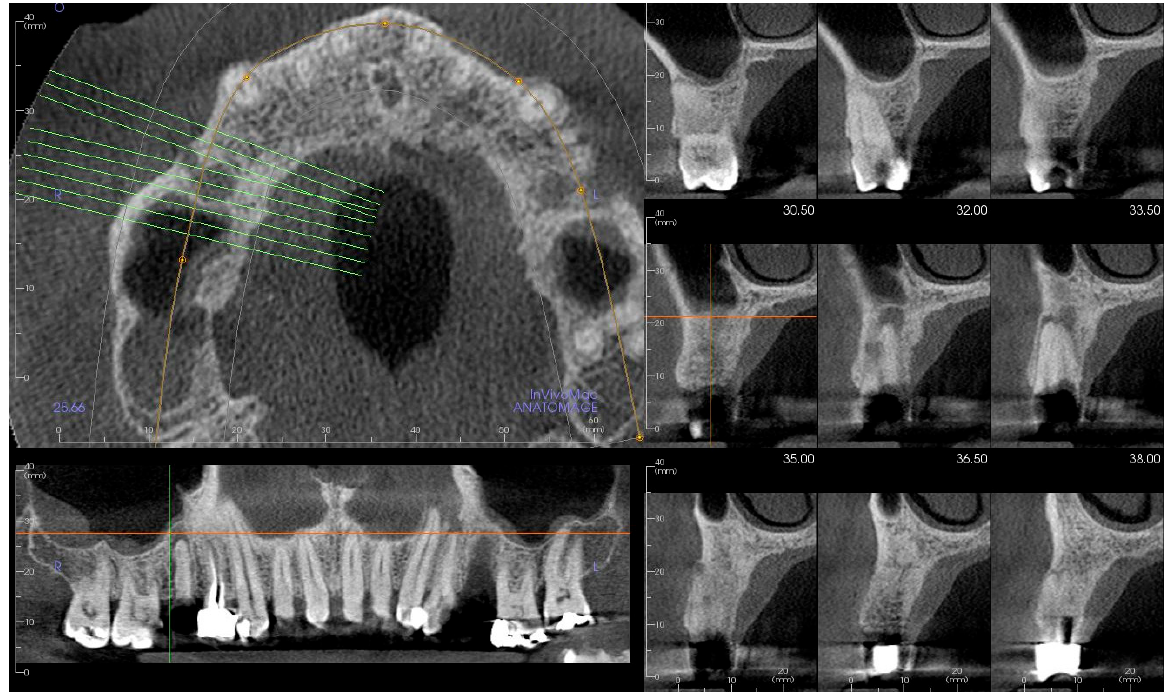
Figure 4. Mucosal thickening: apical disease present. Almost 54% of quadrants, of those that had periapical periodontitis , were associated with mucosal thickening of the adjacent maxillary sinus, compared to 31.6% when there was no periapical periodontitis ( p < 0.001) (df = 1, V = 0.22). The odds ratio for having